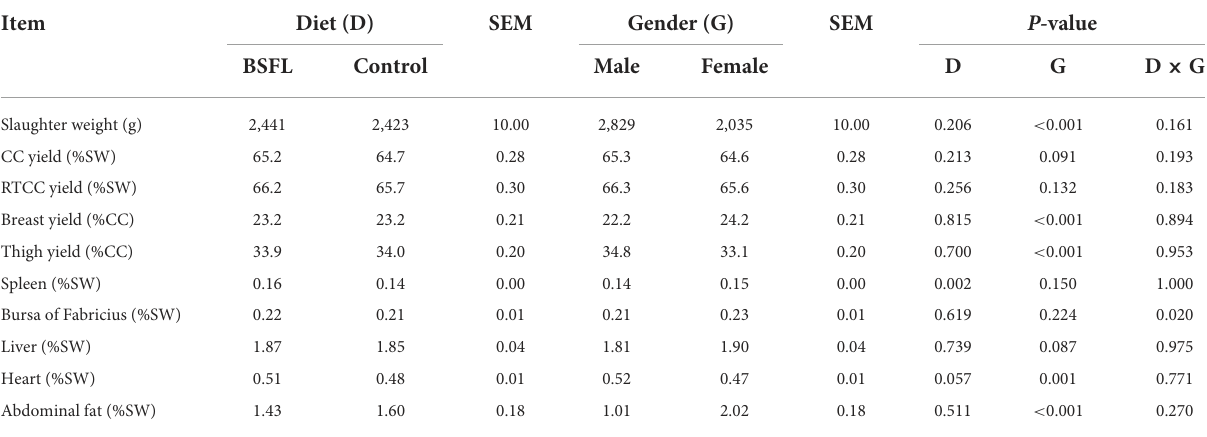
TABLE 4 The slaughtering performance of the male and female Label Rouge Naked Neck birds fed a diet supplemented with 10% live black soldier fly larvae; supplementation based on the expected daily feed intake (28–81d; n =